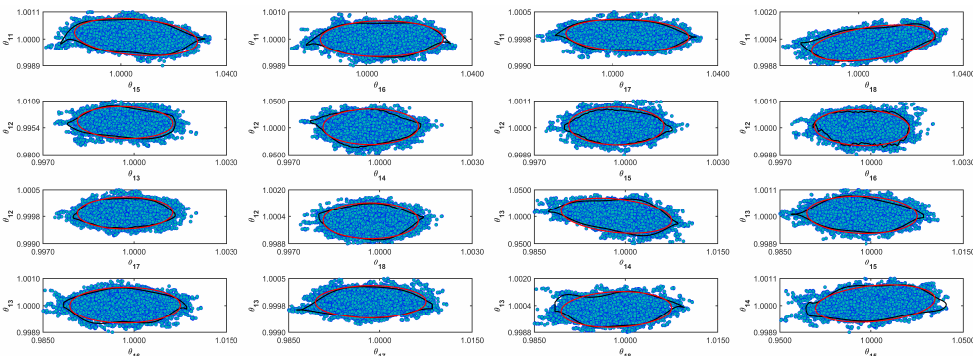
Figure A9. Coverage regions of parameters 09: (—) Gaussian region; (—) Possolo [33] region.